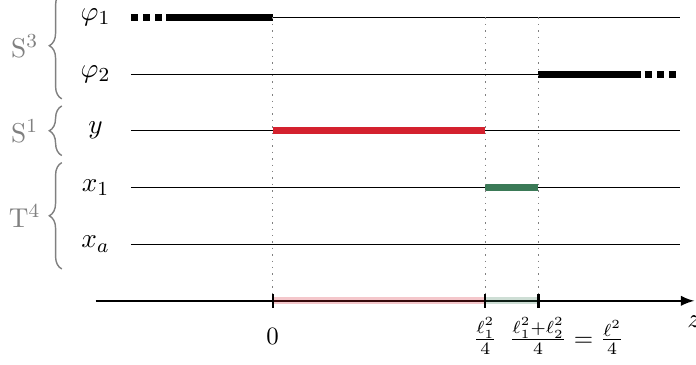
Figure 4 . Rod diagram of the shrinking directions on the z -axis after sourcing the solutions with two connected rods that force the degeneracy of the y and x